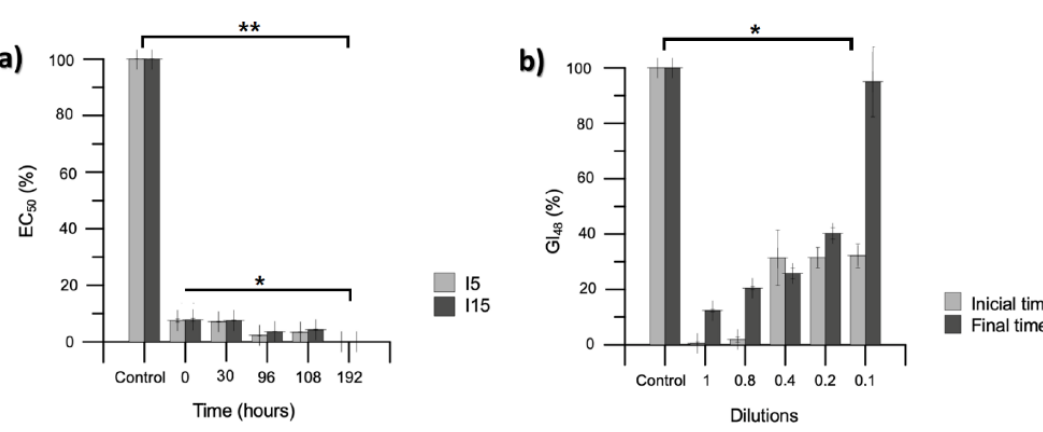
Figure 5. Analysis of the toxicity of effluent inoculated with NSAIDs/analgesic treated with Penicillium oxalicum in a batch feed fluidised bioreactor at different incubation times. ( a ) Microtoxicity of samples taken at 0, 30, 96, 108 192 h; the control corresponds to the measurement of the microtoxicity of the medium without drugs and the fungus. ( b ) Phytotoxicity by calculation of the germination index (GI) at 48 h, the initial time point corresponds to the initial conditions of drug concentration in the bioreactor (250 μM). The final time point corresponds to a value of >99% drug degradation after 192 h of treatment. The control corresponds to the measurement of the GI using distilled water. The values are presented as the average of three independent experiments ± standard deviation ( n = 3). ** = p < 0.01; * = p < 0.05.